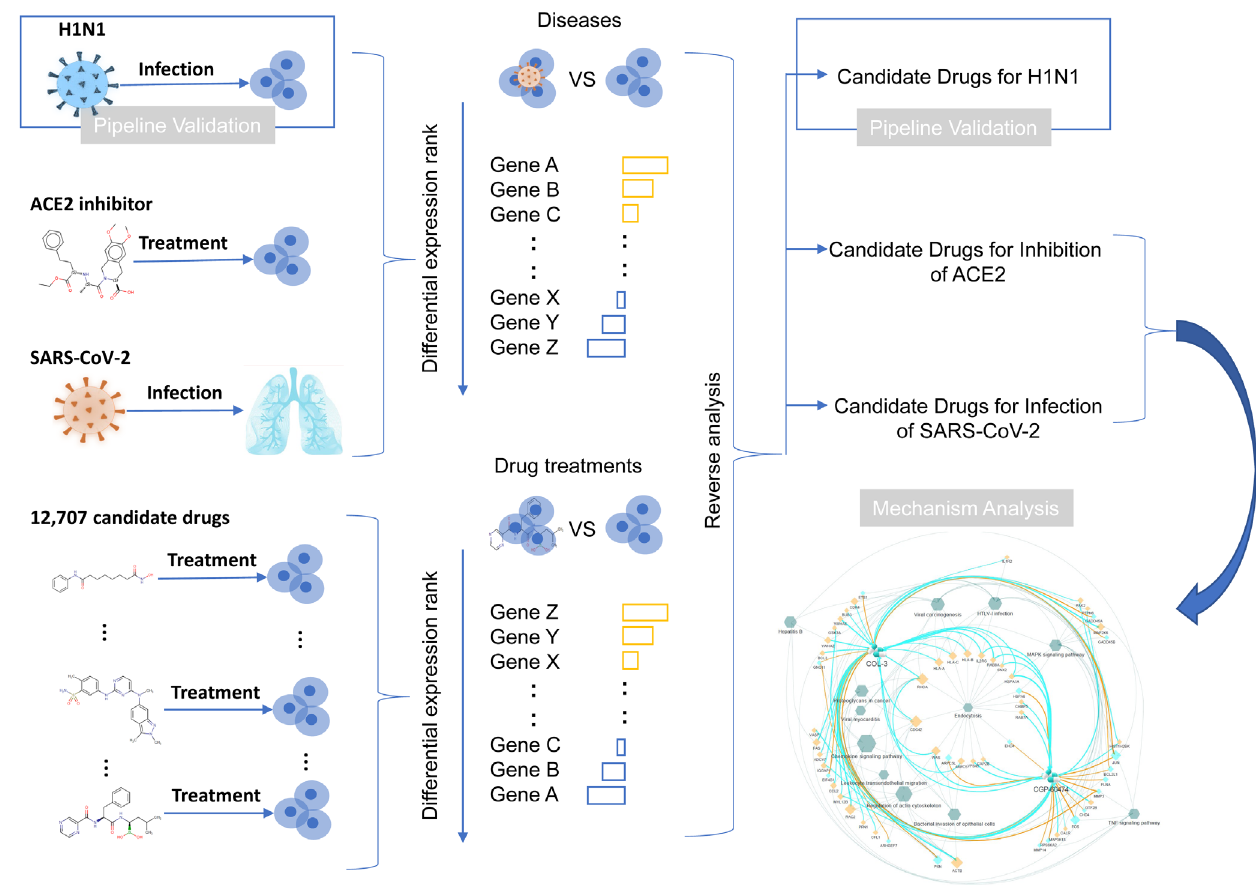
Figure 1. Workflow of repurposing drugs for treating lung injury in COVID-19. Input data include gene expression in A549 cells with H1N1 infection, HCC515 cells with ACE2 inhibitor (ACE2i), human lung tissues of deceased COVID-19 patients and cells with drug treatment. Reversing analysis is conducted to search for drugs that can reverse the gene expression changes upon treatment. The candidate drug to is compared to all other drugs and compounds, in order to estimate its significance level at treating the disease. Candidate drugs for H1N1 are used for validation of the computational pipeline. Candidate drugs identified in both HCC515 cells treated with ACE2 inhibitor and in human lung tissues of deceased COVID-19 patients are used for downstream mechanism analysis.